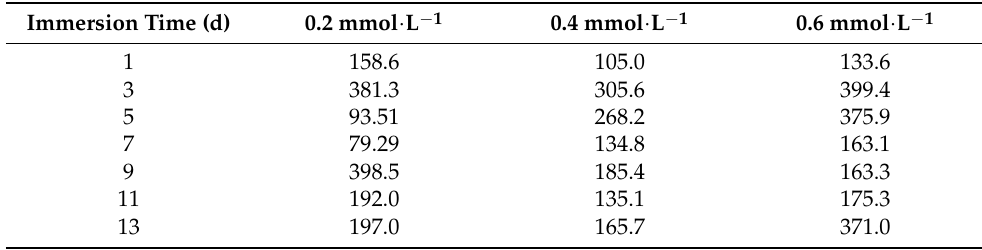
Table 5. R ct values obtained by EIS fitting of magnesium alloy AZ63B immersed in 3.5% NaCl solution with different concentrations of PO 43 − .